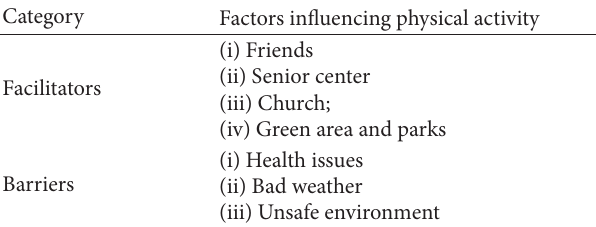
Table 2: Summary of the facilitators of and barriers to physical activity that emerged from the interviews with older African American women ( 𝑛 = 7 ) living in Urbana-Campaign, IL. Category Factors influencing physical activity